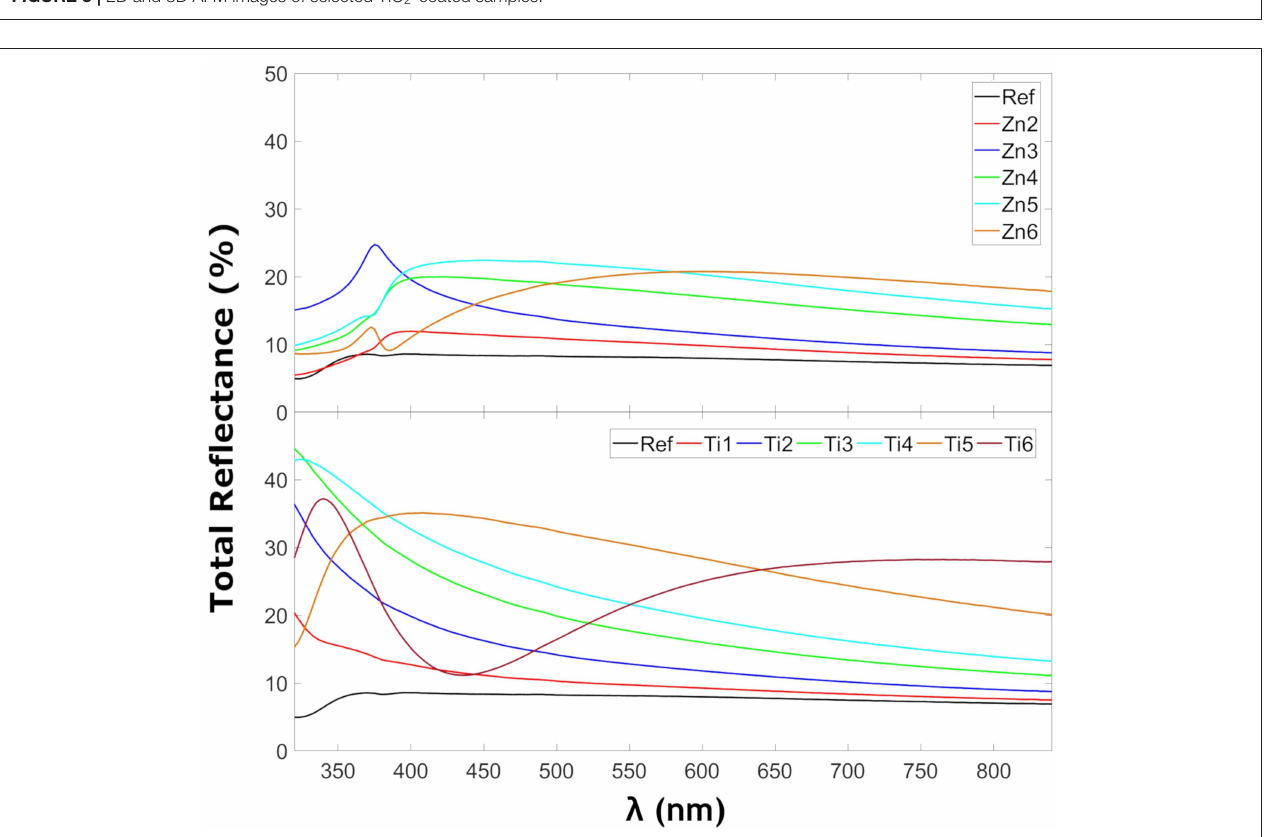
FIGURE 4 | Total reflectance of thin film-coated glass